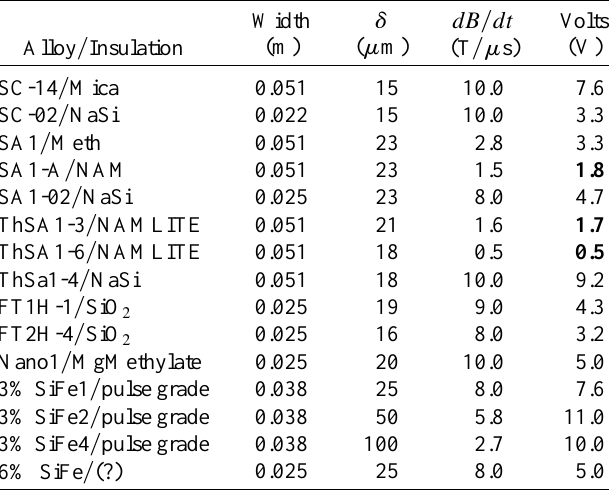
TABLE V. Maximum interlaminar voltage applied without breakdown, or (boldface) at breakdown. The tape thickness is d . The peak value of dB (cid:2) dt and the interlaminar voltage is listed.